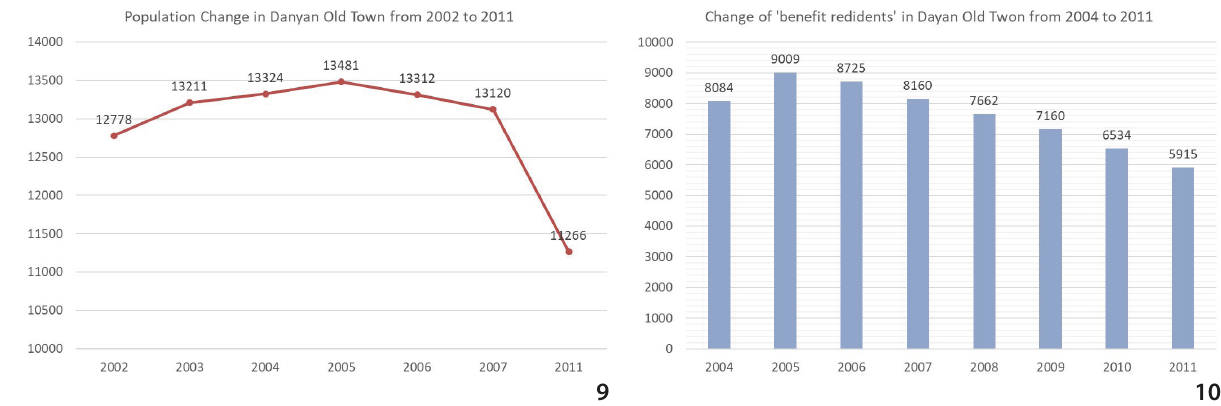
Figure 9 Evolution of the total population of Dayan Old Town, between 2003–2011 (Units: person) (Source: Drawn by the author according to the Statistical Yearbooks and Statistical Bulletins of Lijiang Municipality and Gucheng District). Figure 10 The population of ‘benefited residents’ of Dayan Old Town from 2004 to 2007 (Units: person) (Source: Drawn by the author according to the Statistical Yearbooks and Statistical Bulletins of Lijiang Municipality and Gucheng